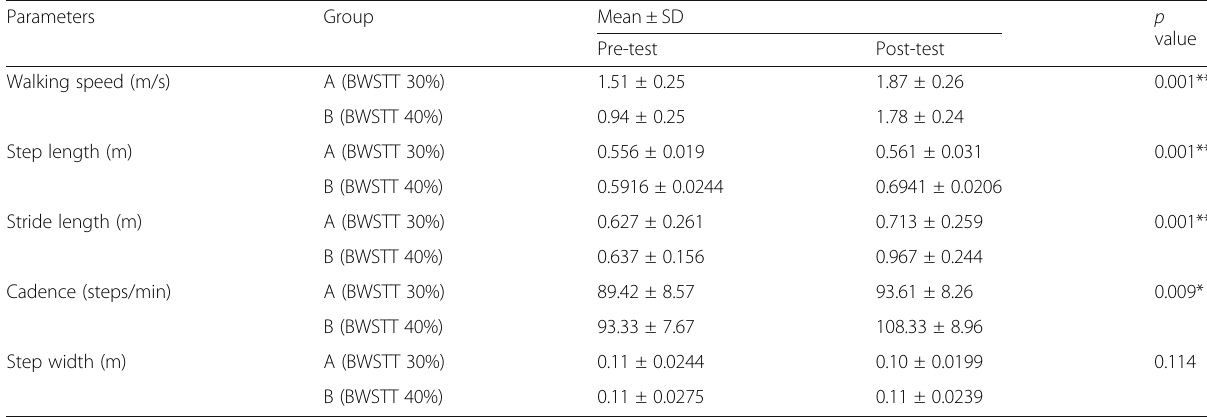
Table 1 The comparability of statistical changes pre-test and post-test in the outcome parameters pre and post 6 weeks of